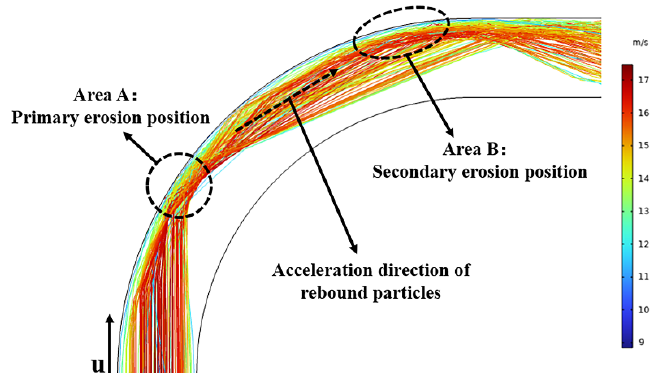
Figure 15. Cross-sectional view of collision trace of particle and elbow at R D = 8.